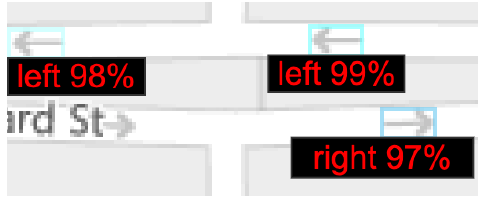
Figure 14. Arrow direction detection for Bing